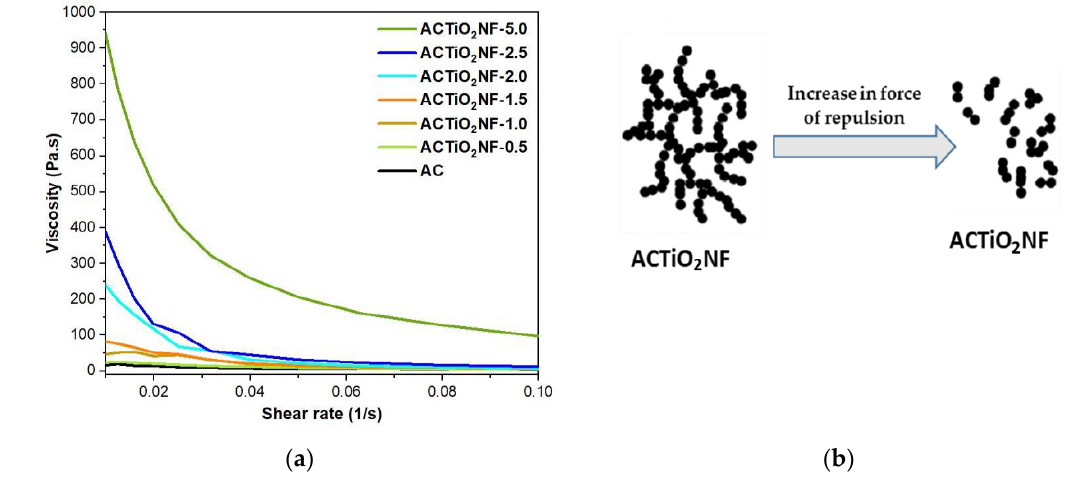
Figure 6. ( a ) Rheological properties of the flow-electrodes. ( b ) Schematic diagram of the ACTiO 2 NF mixture behavior under repulsive forces.